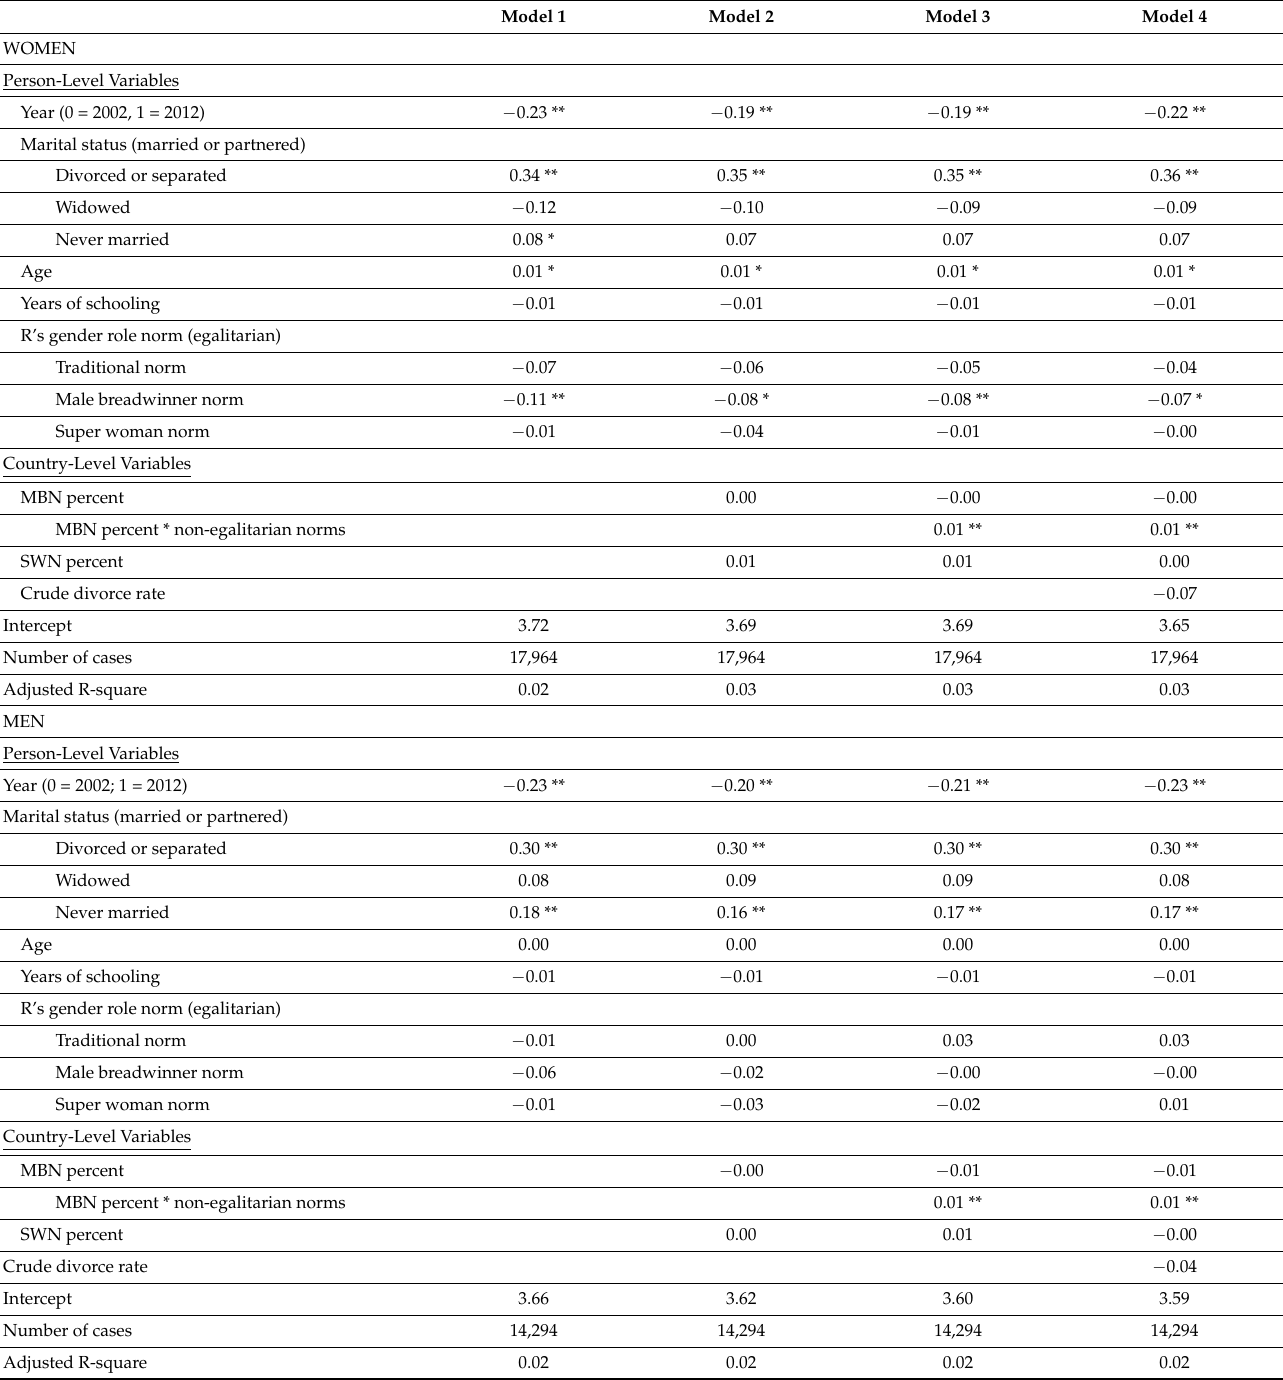
Table 3. Robust regression of approving attitudes toward divorce as the best solution on gender Role norms and explanatory